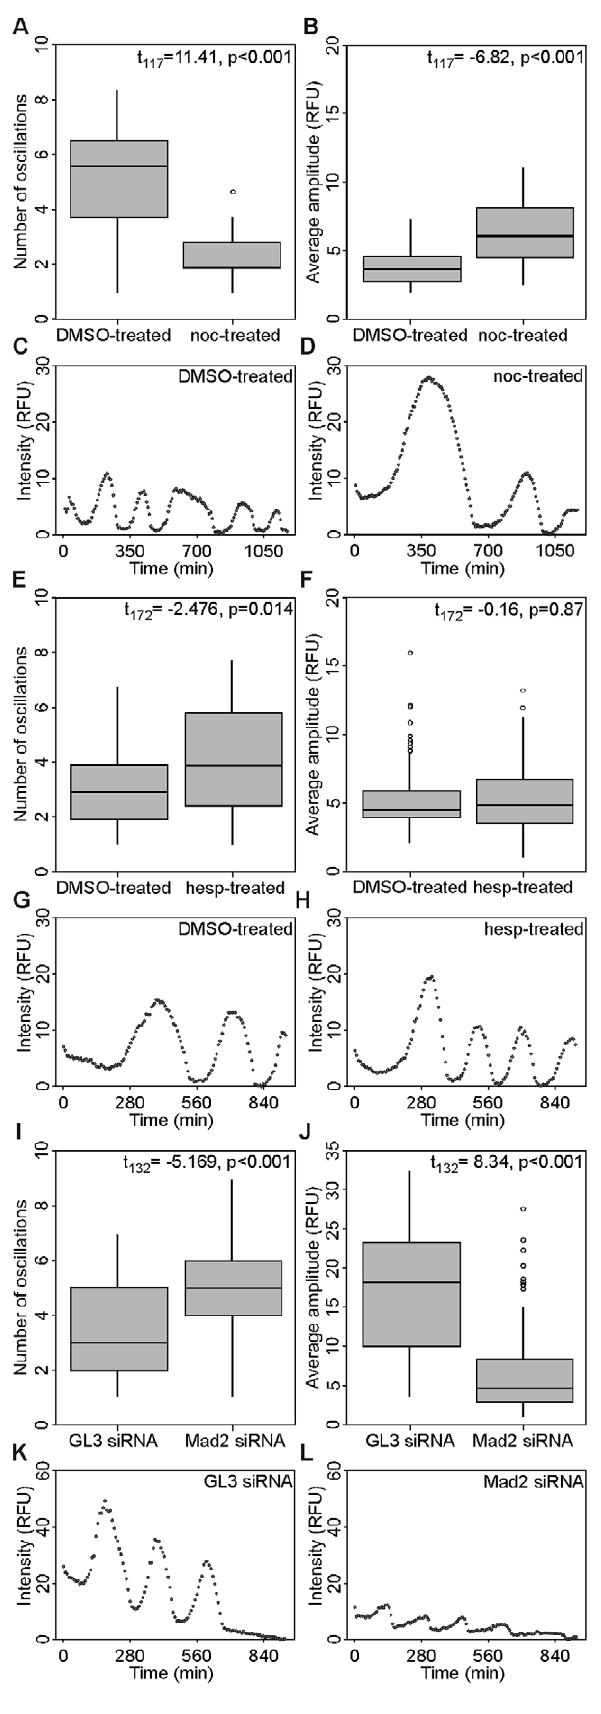
Figure 5. Mad2 knockdown in G1 cells with impaired APC-Cdh1 activity increases cyclin B1-YFP oscillation frequency. (A) Box plots of cyclin B1-YFP oscillation peak frequencies in DMSO- and nocodazole-treated cells, respectively. DMSO (oscillations per experi- ment (OPE)): range, 0.92–8.35; first quartile, 3.71; median, 5.56, third quartile, 6.49. Nocodazole (OPE): range, 0.92–3.71; first quartile, 1.85; median, 1.85; third quartile, 2.78. (B) Box plots of cyclin B1-YFP oscillation amplitudes in DMSO- and nocodazole-treated cells, respec- tively. DMSO (relative fluorescence units (RFU)): range, 1.9–7.3; first quartile, 2.7; median, 3.6, third quartile, 4.5. Nocodazole (RFU): range, 2.4–10.9; first quartile, 4.4; median, 6.0; third quartile, 8.1. (C, D) Representative cells oscillating at the median frequency in the DMSO and nocodazole treatments, respectively. (E) Box plots of cyclin B1-YFP oscillation peak frequencies in DMSO- and hesperadin-treated cells. DMSO (OPE): range, 0.96–6.74; first quartile, 1.92; median, 2.88, third quartile, 3.85. Hesperadin (OPE): range, 0.96–7.7; first quartile, 2.4; median, 3.85; third quartile, 5.77. (F) Box plots of cyclin B1-YFP oscillation amplitudes in DMSO- and hesperadin-treated cells, respec- tively. DMSO (RFU): range, 2.0–8.5; first quartile, 3.9; median, 4.4, third quartile, 5.8. Hesperadin (RFU): range, 1.0–11.2; first quartile, 3.5; median, 4.8; third quartile, 6.6. (G, H) Representative cells oscillating at median frequency in the DMSO and hesperadin treatments, respec- tively. (I) Box plots of cyclin B1-YFP oscillation peak frequencies in GL3- and Mad2 d-siRNA-treated cells. GL3 (OPE): range, 0.99–6.94; first quartile, 1.98; median, 2.97, third quartile, 4.96. Mad2 (OPE): range, 0.99– 8.92; first quartile, 3.96; median, 4.96; third quartile, 5.95. (J) Box plots of cyclin B1-YFP oscillation amplitudes in GL3- and Mad2 d-siRNA-treated cells, respectively. GL3 (RFU): range, 3.5–32.4; first quartile, 9.9; median, 18.0, third quartile, 23.2. Mad2 (RFU): range, 0.9–14.9; first quartile, 2.9; median, 6.9; third quartile, 8.3. (K, L) Representative cells oscillating at median frequency in the GL3- and Mad2-d-siRNA treatments, respec- tively. In (A), (F), and (J), outliers that are at least 1.5 times the interquartile distance away from their respective quartiles are presented as (Figure 6A, B; blue ‘‘M’’ gate). CDK1AF-transfection produced nearly 5% with pHH3-positive-plus-G1/S DNA content, in contrast to 0.05% in the CDK1WT-transfected sample (Figure 6A, B; green ‘‘G1/S’’ gate). All cells from each respective treatment (all cells shown in Figs. 6A, B) were then plotted as a function of DNA (PI) and Wee1 content (Figure 6C, D; red), and the pHH3-positive/cell-cycle-gated subsets were then overlaid on these plots. G1/S pHH3-positive cells from the CDK1WT- transfected population were negligible (Figure 6C; green). M- phase pHH3-positive cells, however, were abundant and con- tained low Wee1 protein content in contrast to cells with high DNA content (Figure 6C; compare ‘‘blue’’ to ‘‘red’’ scatters) – the central axis of this population was defined as the ‘‘M-phase Wee1 level’’ (Figure 6C, D; gray hashed line). Not only did CDK1AF- transfected cells that were M-phase pHH3-positive follow suit (Figure 6D; blue), but the subset of cells that represented the improper cycling daughter cells—G1/S pHH3-positive—also contained a low abundance of Wee1 (Figure 6D, green). Plotting Wee1 contents of the CDK1AF-transfected cells (Figure 6D) as a histogram confirmed that peak Wee1 levels of the M-phase- and G1/S-pHH3-positive cells were nearly identical, with both lower than the Wee1 content of normal S-phase cells (Figure 6E). These data supported that the G1 cells undergoing precocious spindle formation contained negligible Wee1 kinase (i.e., were at or below the level found in normal mitotic cells), as also is the case in G1 phase during normal cell cycle progression. Thus, the normal degradation of Wee1 kinase during mitosis reinforces the need for proper APC function to mediate the destruction of mitotic